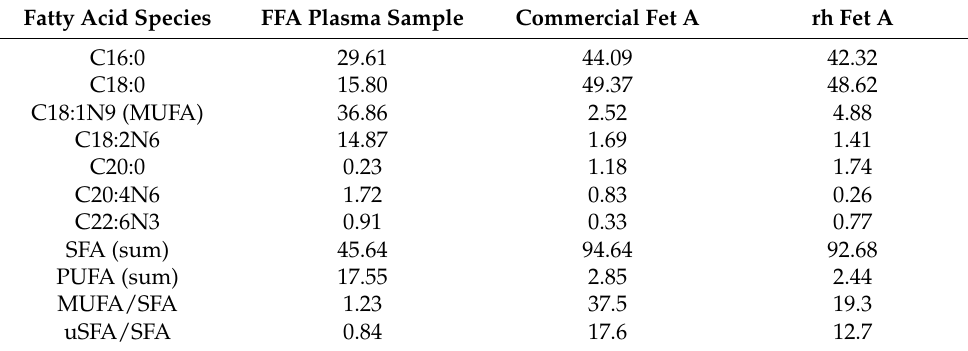
Table 4. Free fatty acid pattern of human serum from a healthy individual and Fet A preparations. Percentages of the main free fatty acids of human serum, Fet A from Sigma-Aldrich, and rhFet A are